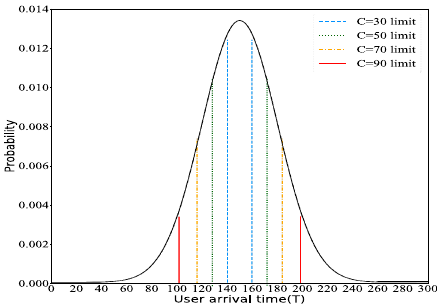
Figure 2. Probability distribution of user arrival time.